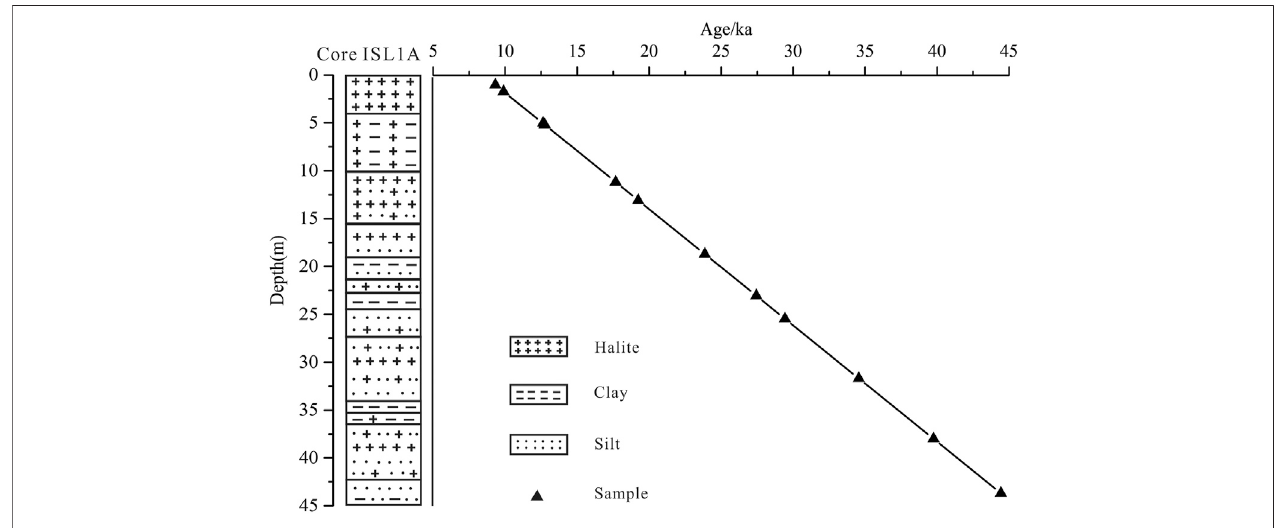
FIGURE 5 | Age and depth of halite samples in this study.